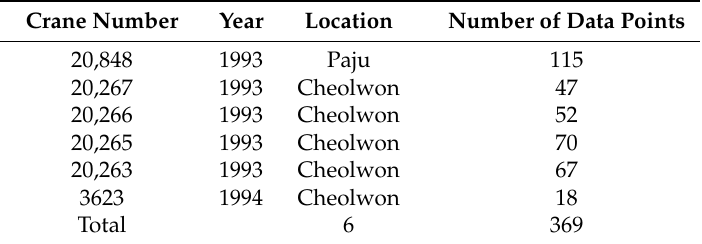
Table 1. Number of signals, year, area of red-crowned crane species.